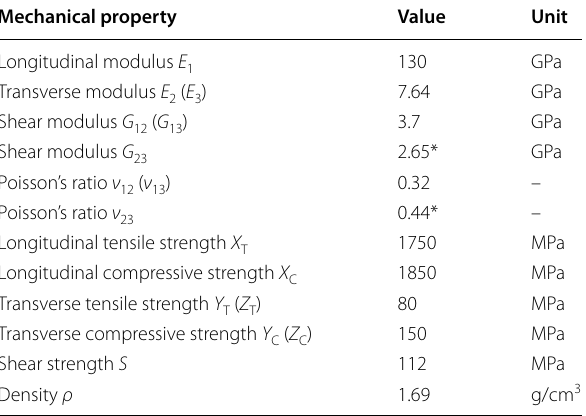
Table 1 Mechanical properties of the carbon fiber/epoxy composite laminate [29, 30]